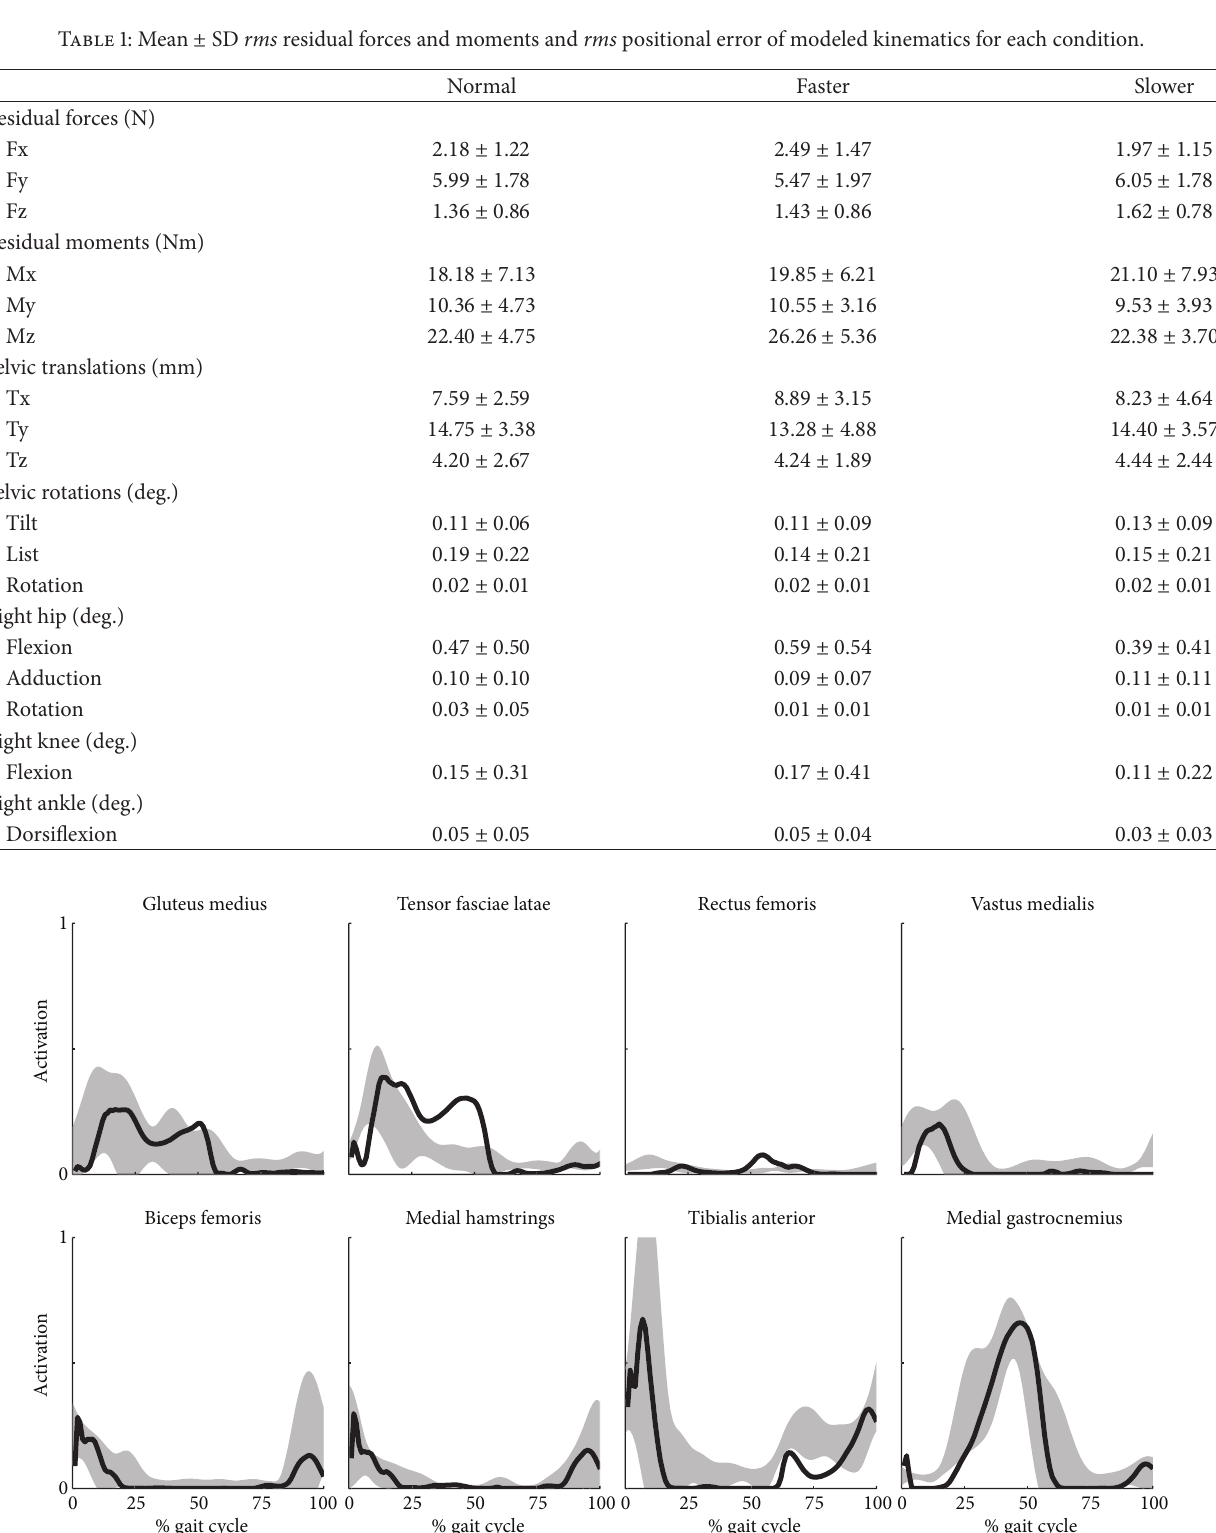
Figure1:Ensemblesimulatedmuscleactivationsfromcomputedmusclecontrol(solidline)andexperimentallymeasuredEMG(shadedarea) during normal conditions. Shaded regions represent ± 1 standard deviation of the mean EMG for nine subjects. EMG data were normalized to the muscle specific maximum-recorded signal during MVIC testing. Activations are represented on a spectrum of 0 (fully deactivated) to 1 (fully